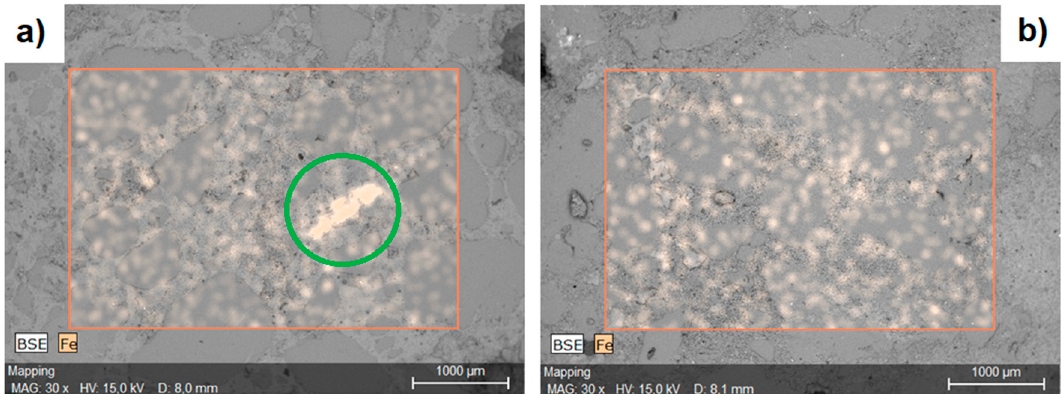
Figure 7. A map of Fe distribution in the cement mortar containing nano-Fe 3 O 4 : ( a ) a visible agglomerate of nano-Fe 3 O 4 in the cement matrix; ( b ) a uniform distribution of the nanomaterial in the matrix (Reprinted with permission from [40]).